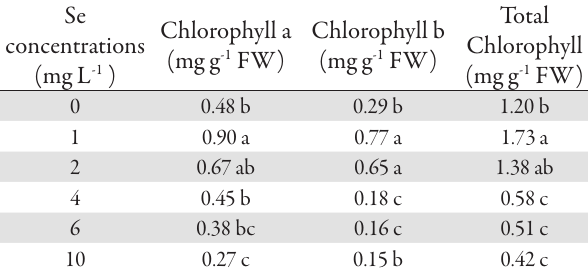
Fig. 2. Effect of selenium supplementation on total phenolic compounds in shoots and roots of spinach